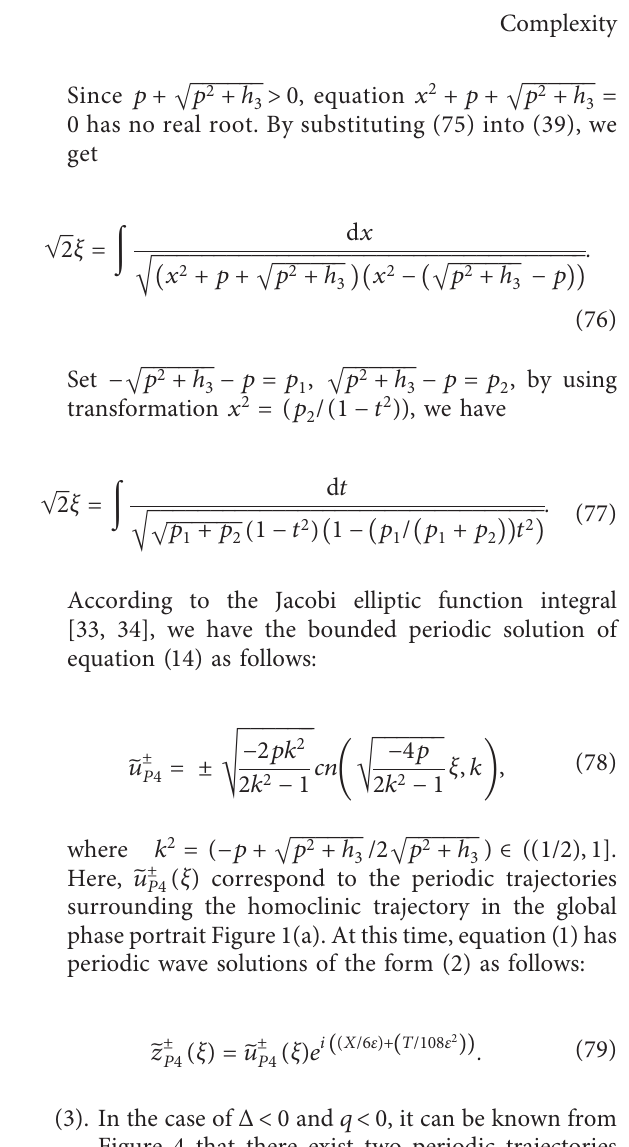
and 3 � H ( x , 0 ) 3 1